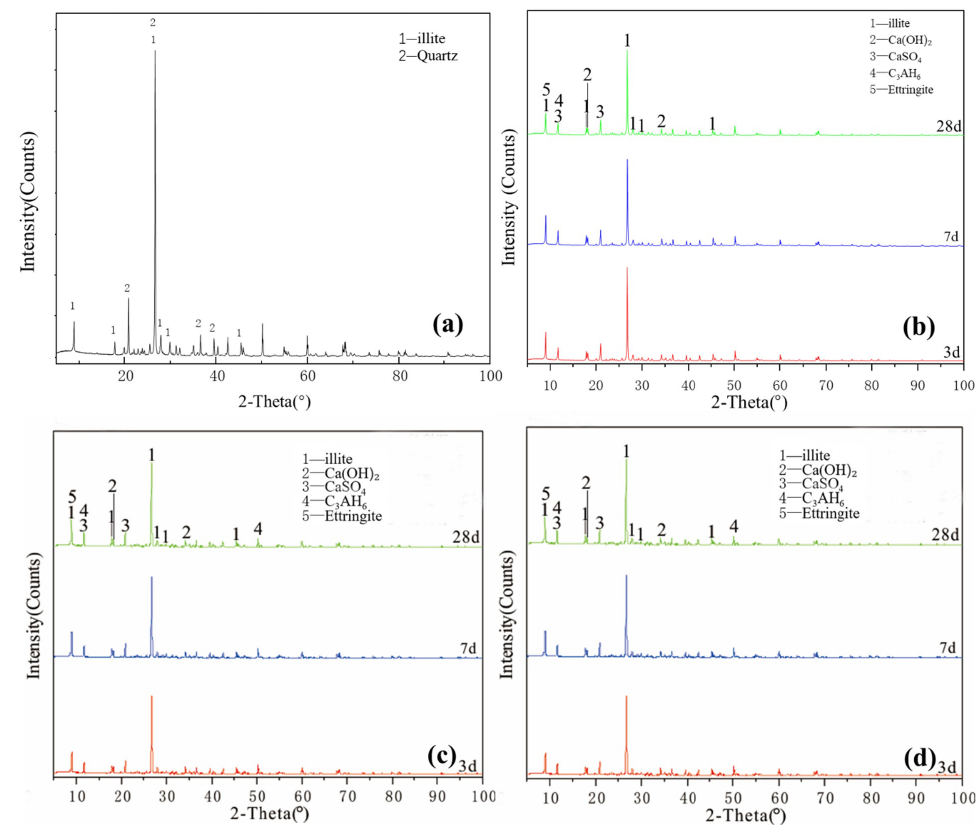
Figure 4. XRD patterns of illite: ( a ) raw material, ( b ) 3-, 7- and 28-day curing age Y0, ( c ) 3-, 7- and 28-day curing age Y1, ( d ) 3-, 7- and 28-day curing age Y1-2.